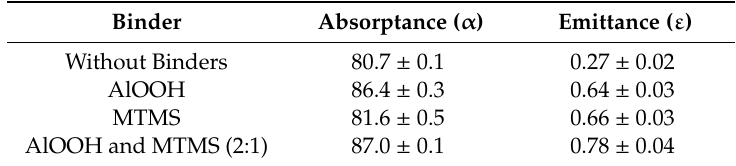
Table 1. E ff ect of binder type for water-based formulations containing 0.032% CNTs on the selective Table 1. Effect of binder type for water-based formulations containing 0.032% CNTs on the selective properties of the coatings. Binder / CNT ratio was Table 1. Effect of binder type for water-based formulations containing 0.032% CNTs on the selective properties of the coatings. Binder/CNT ratio was 8.4:1. Table 1. Effect of binder type for water-based formulations containing 0.032% CNTs on the selective properties of the coatings. Binder/CNT ratio was 8.4:1. properties of the coatings. Binder/CNT ratio was 8.4:1.